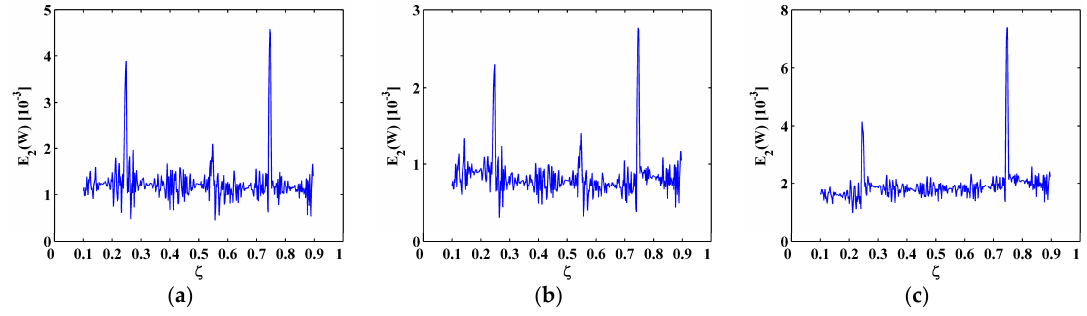
Figure 8. MRM-TKE for the ( a ) sixth; ( b ) seventh; and ( c ) eighth mode shapes with 55 dB SNR.